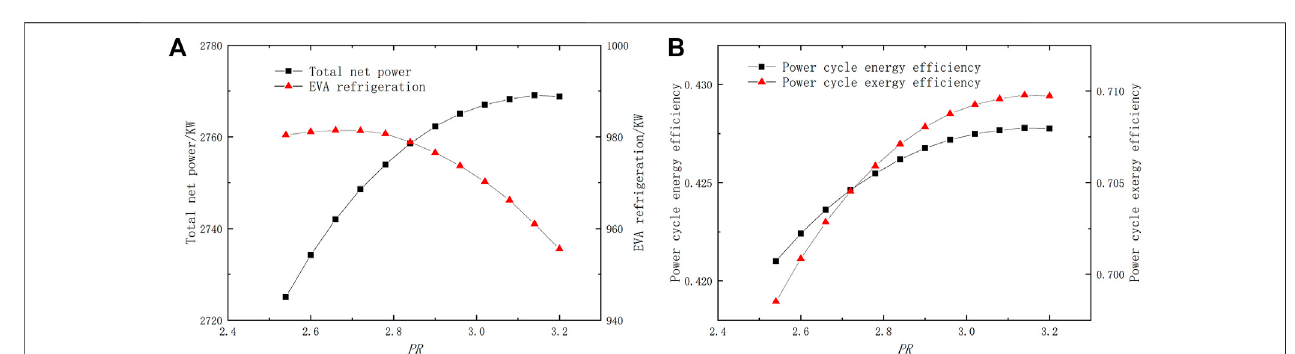
FIGURE 8 | Effect of RSCO 2 pressure ratio PR